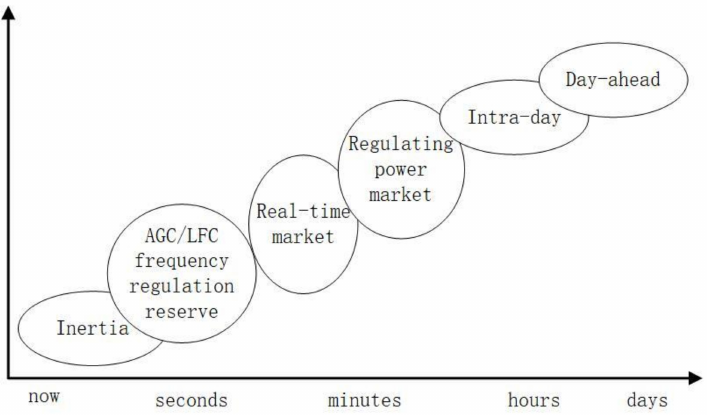
Figure 1. Traditional power system operation on a